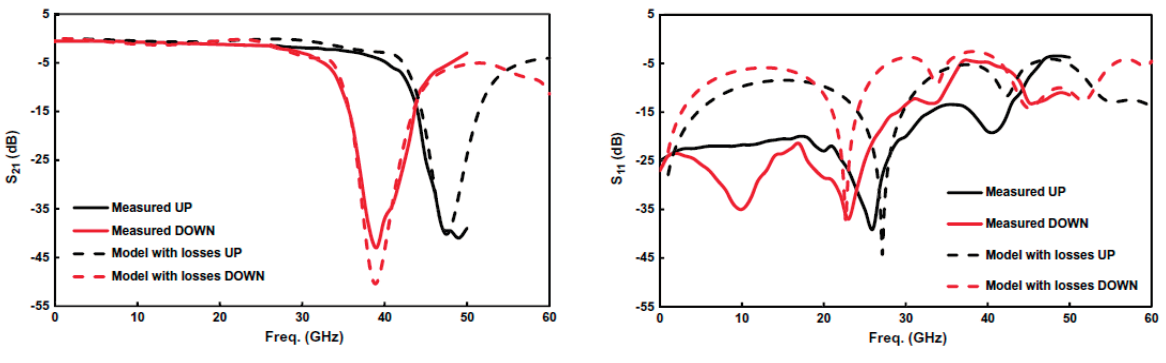
Figure 6. Comparison between the circuit model response (including losses) and the measured response for the designed stop-band reconfigurable CSRR/RF-MEMS based filter. ( a ) Insertion loss; ( b ) return loss. From [18], reprinted with